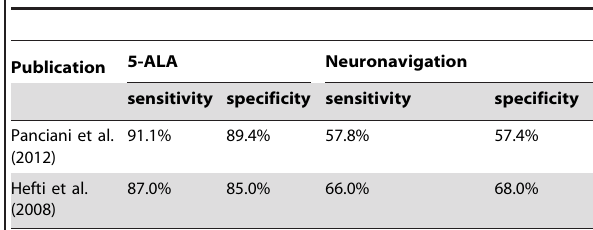
Table 4. Detection of tumor lesions in comparison of the administration of 5-ALA with conventional